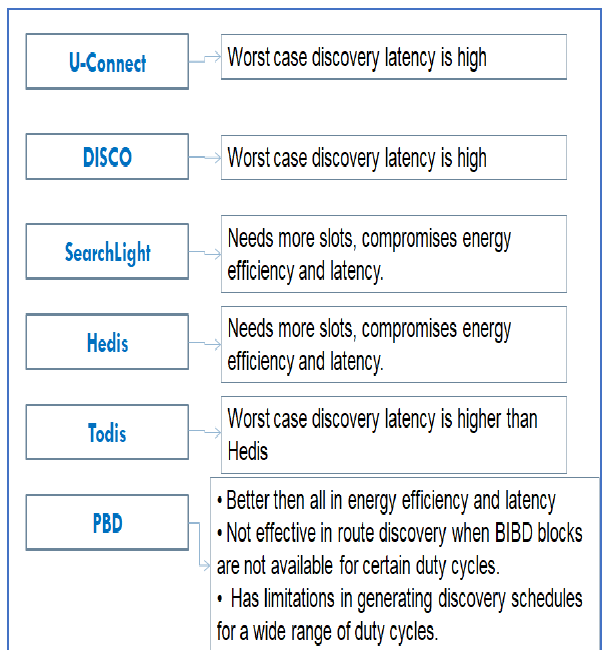
Figure 6. Summary of